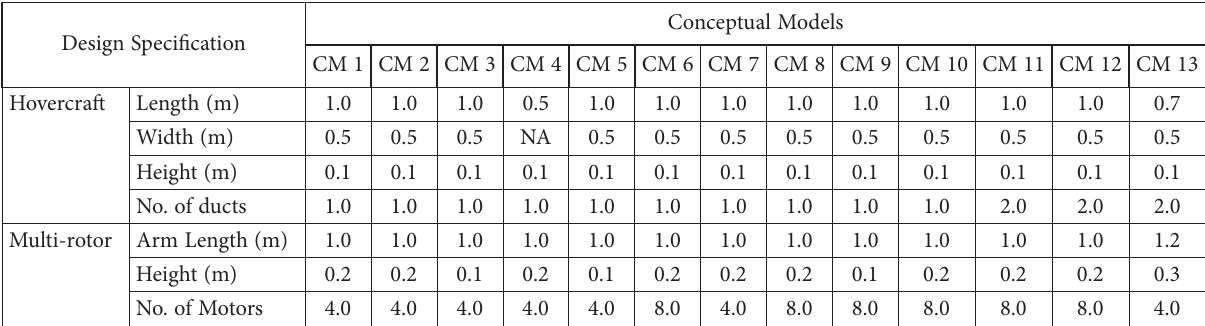
Table A3. Design specifications of conceptual models